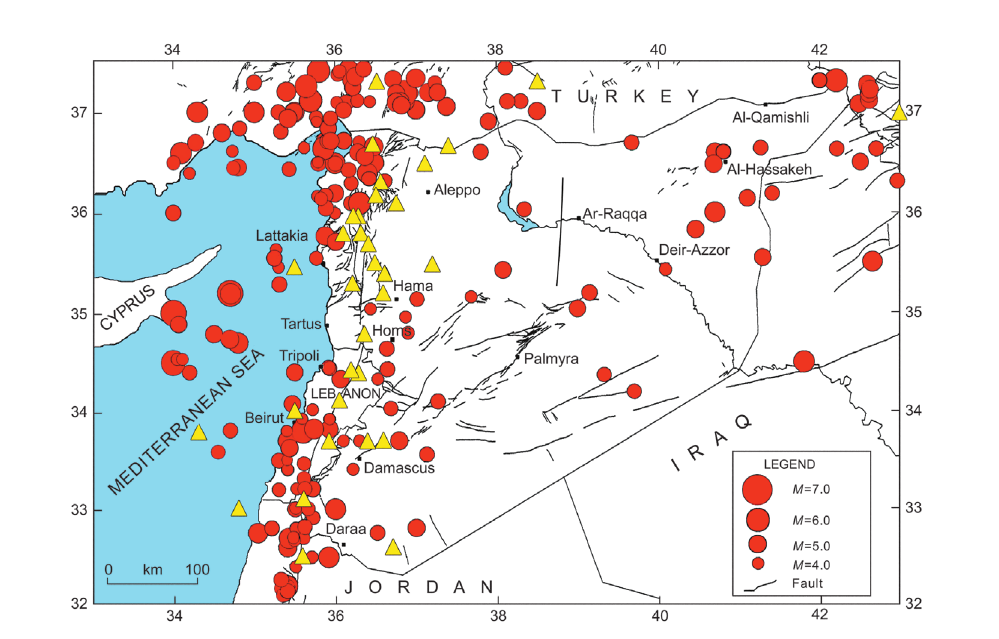
Fig. 22. Map of instrumental (red circles) and historical (yellow triangles) seismicity of Syria and surrounding